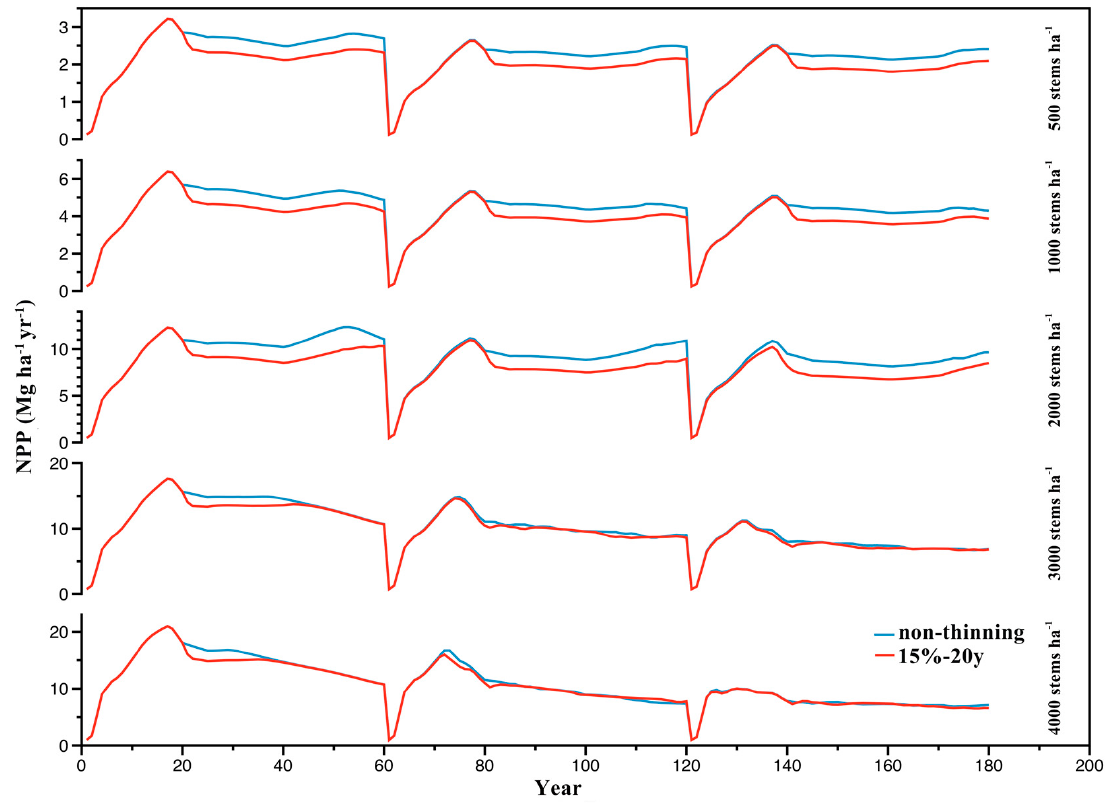
Figure 2. Changes in net primary productivity (NPP) in stands with different initial densities in three rotations. Blue lines represent non-thinning, red lines represent 15% thinning intensity and 20th year of application of thinning in a rotation.